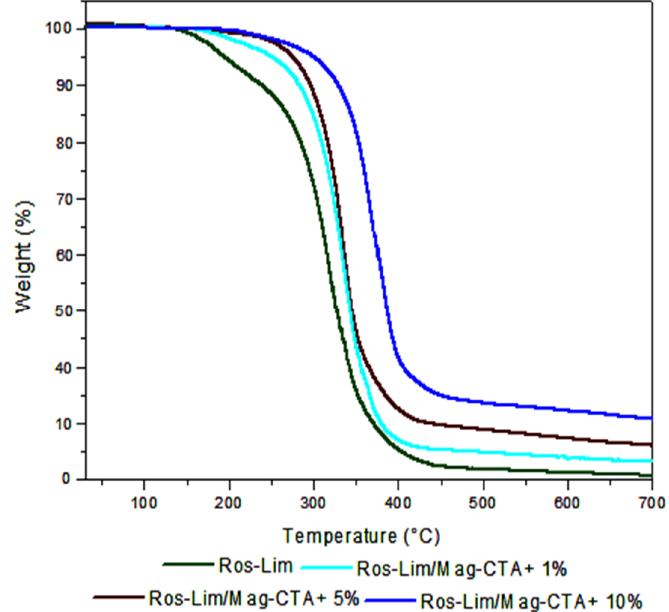
Figure 7. Thermogravimetric analysis (TGA) curves of Ros-Lim copolymer and Ros-Lim / Mag-CTA + (1, 5 and 10%).